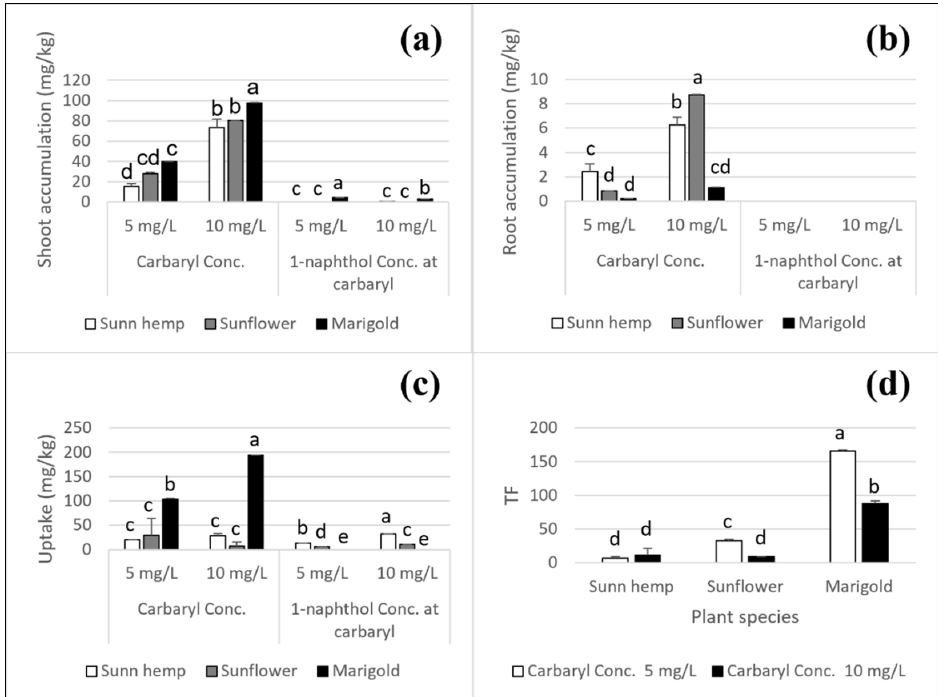
Figure 6. Carbaryl and 1-naphthol accumulation in plants after 4 days of cultivation for carbaryl treatments at 5 and 10 mg L −1 ; shoot accumulation ( a ), root accumulation ( b ), uptake capacity ( c ), and translocation factor ( d ). Note: a, b, c, d, and e indicate significant differences based on ANOVA and Tukey's HSD test. The data shown are mean and SD.